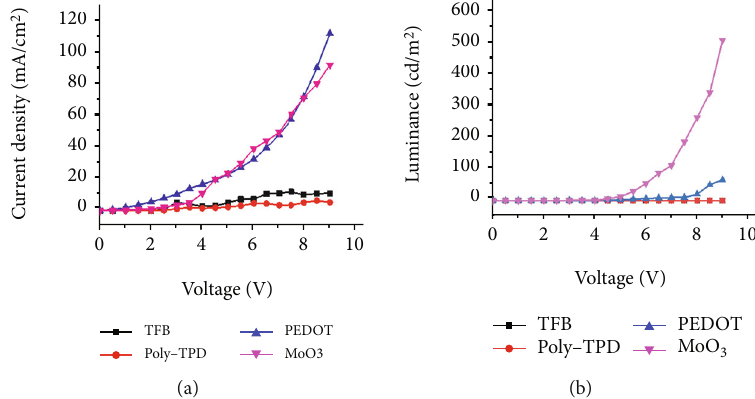
Figure 5: (a) Current density-voltage curves and (b) luminance-voltage curves of TE-OLED with various hole injection materials